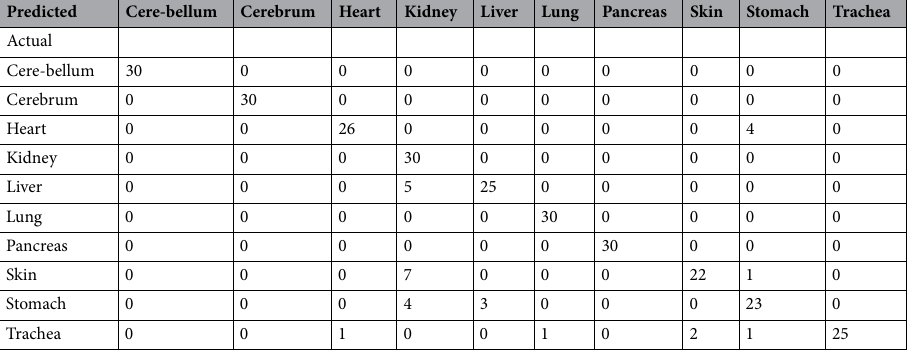
Table 4. Confusion matrix of IML on the validation set ( n =